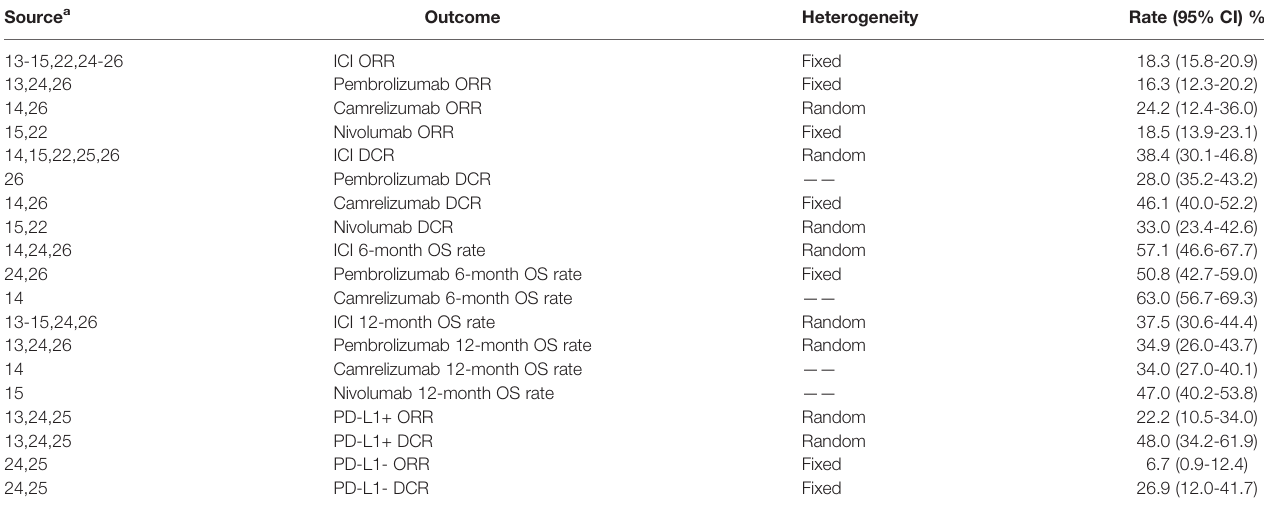
TABLE 2 | ORR, DCR and OS rate in different subgroups.